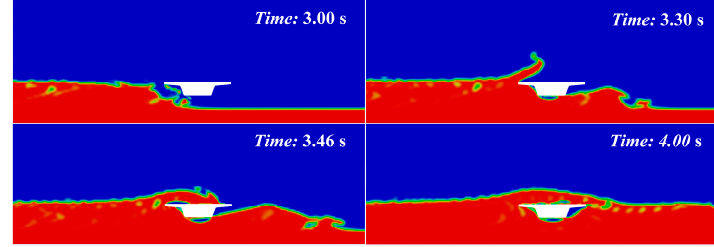
Figure 12. Snapshots of the tsunami-like wave impacting the bridge.